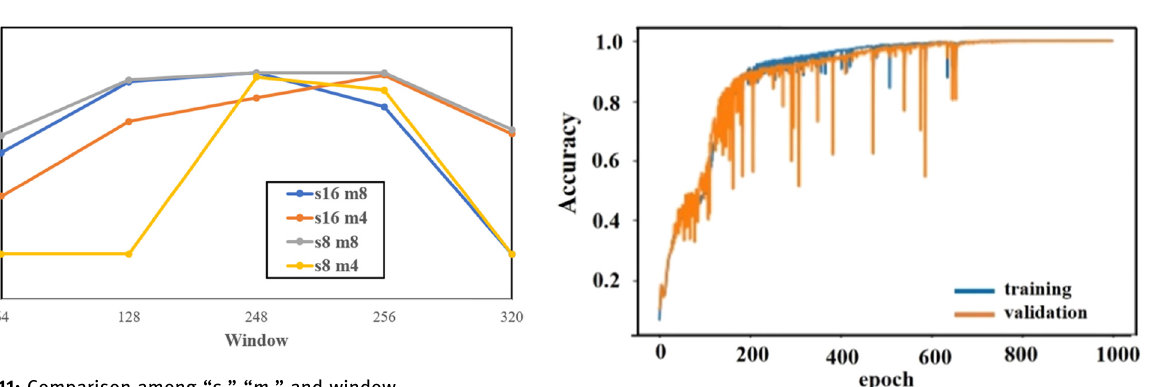
Figure 11: Comparison among “ s , ” “ m , ” and window.